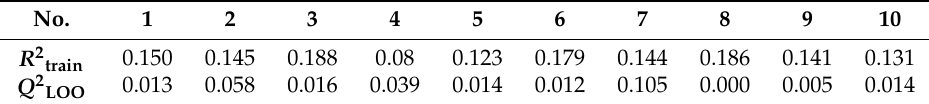
Table 5. R 2 train and Q 2 LOO values after Several Y-randomization